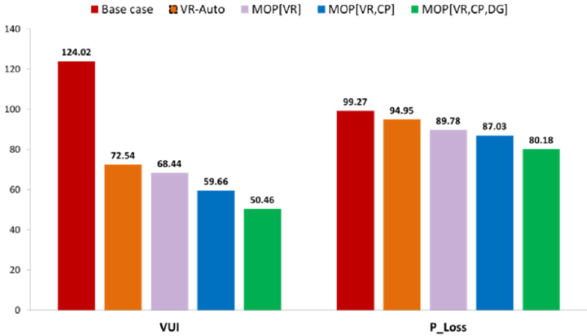
Figure 7. Values of objective functions of Pareto optimal solutions for each case of voltage regulation.